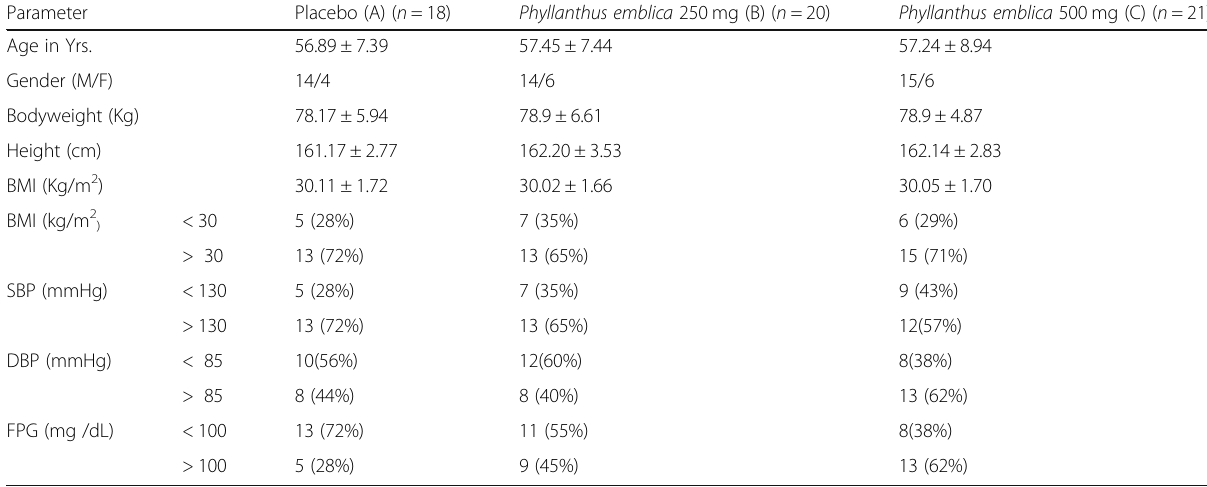
Table 1 Baseline characteristics of subjects receiving Placebo, Phyllanthus emblica 250 mg and Phyllanthus emblica 500 mg